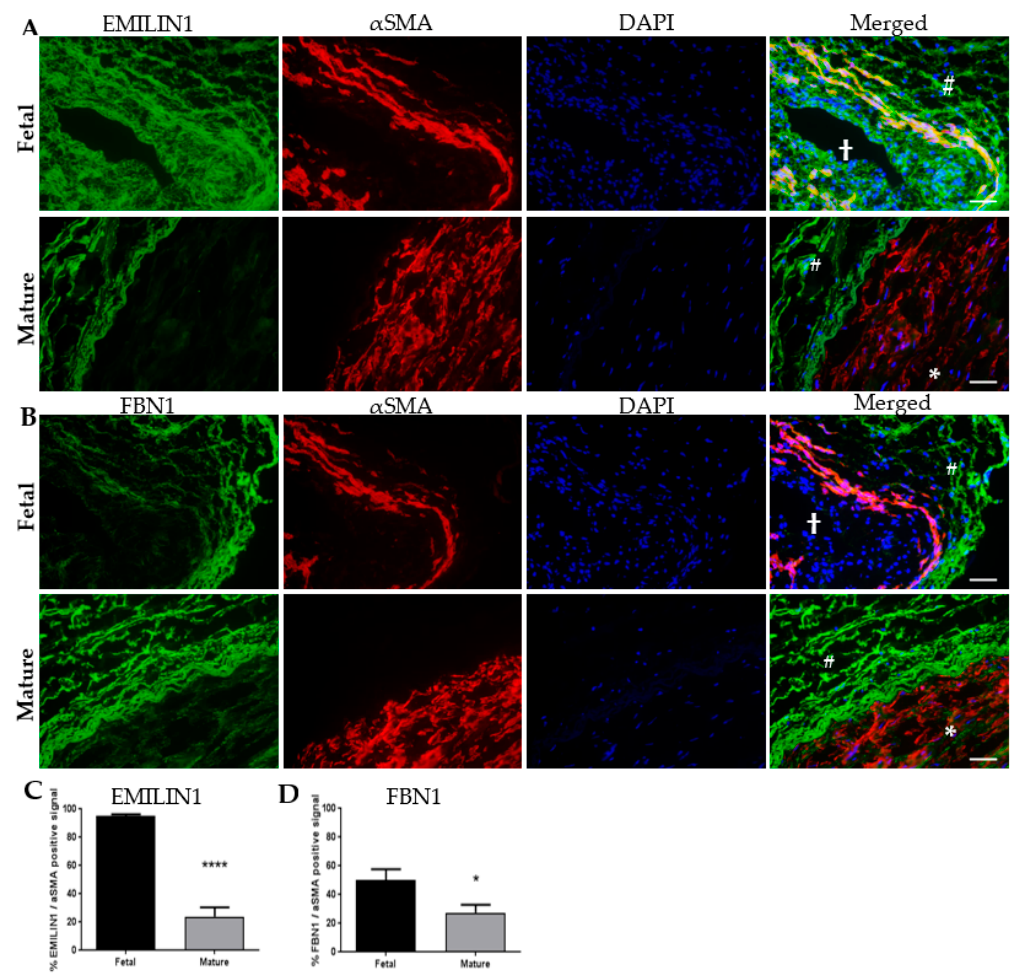
Figure 3. ( A ) Representative images demonstrate the distribution of EMILIN1 co-stained with smooth muscle actin ( α SMA) in fetal and mature human renal arteries. Co-localization of α SMA and EMILIN1 in yellow. ( B ) Representative images demonstrate the distribution of FBN1 co-stained with α SMA in fetal and mature human renal arteries. Co-localization of α SMA and FBN1 in yellow. Scale bar represents 50 µ m. Open lumen is indicated with a cross, tunica media layer is indicated with an asterix, and the tunica adventitia layer is indicated with a pound sign. ( C ) Quantification of EMILIN1 and α SMA positive signal in percentages in fetal and mature renal arteries. ( D ) Quantification of FBN1 and α SMA positive signal in percentages in fetal and mature renal arteries. Data are shown as mean ± SEM, N = 4–5 fluorescent images for EMILIN1 and FBN1 respectively, in fetal samples. N = 11–15 fluorescent images for EMILIN1 and FBN1 respectively, in mature samples. * p < 0.05, **** p < 0.0001 (Student’s t -test).